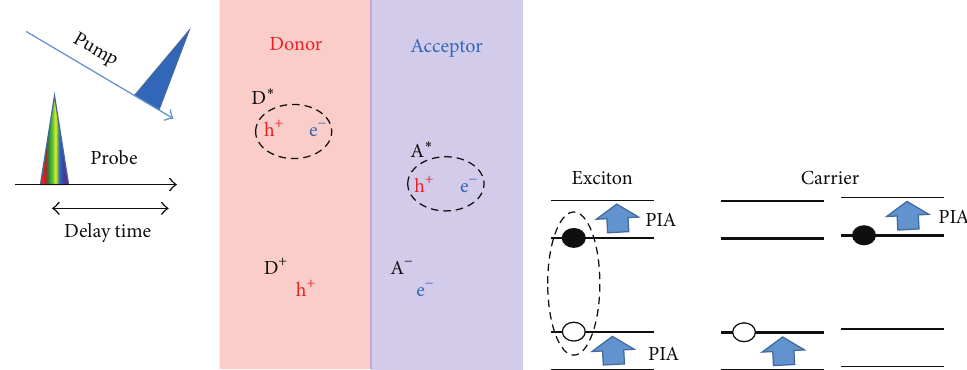
Figure 2: Schematic diagram of the transient absorption spectroscopy. Photoexcitation generates donor exciton (D ∗ ), acceptor exciton (A ∗ ), donor hole (D + ), and acceptor electron (A − ). Right panel shows energy level diagram for exciton and carrier together with photoinduced absorption